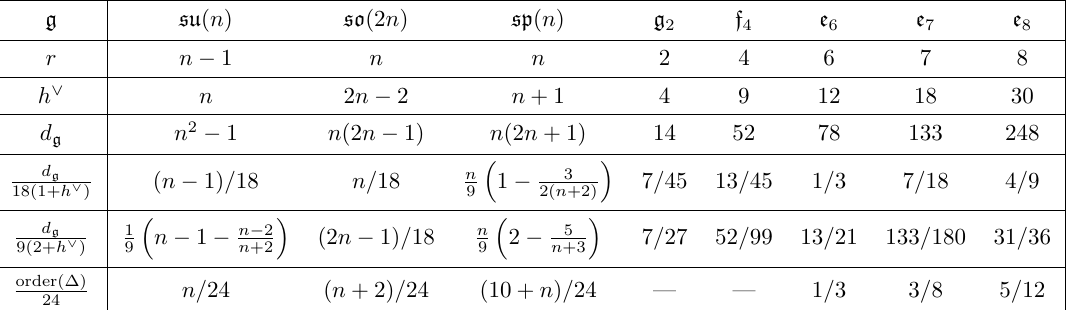
Table 1 . Group theory factor. Here r, h ∨ , and d g are the rank, dual Coxeter number, and the dimension of the group, respectively. The third and fourth rows are the central charges of the current algebra (2.1) divided by 18 (which is the maximum allowed by unitarity) with levels one and two, respectively. The last row is related to a 3-brane bound we will provide, see section 3 and discussion around